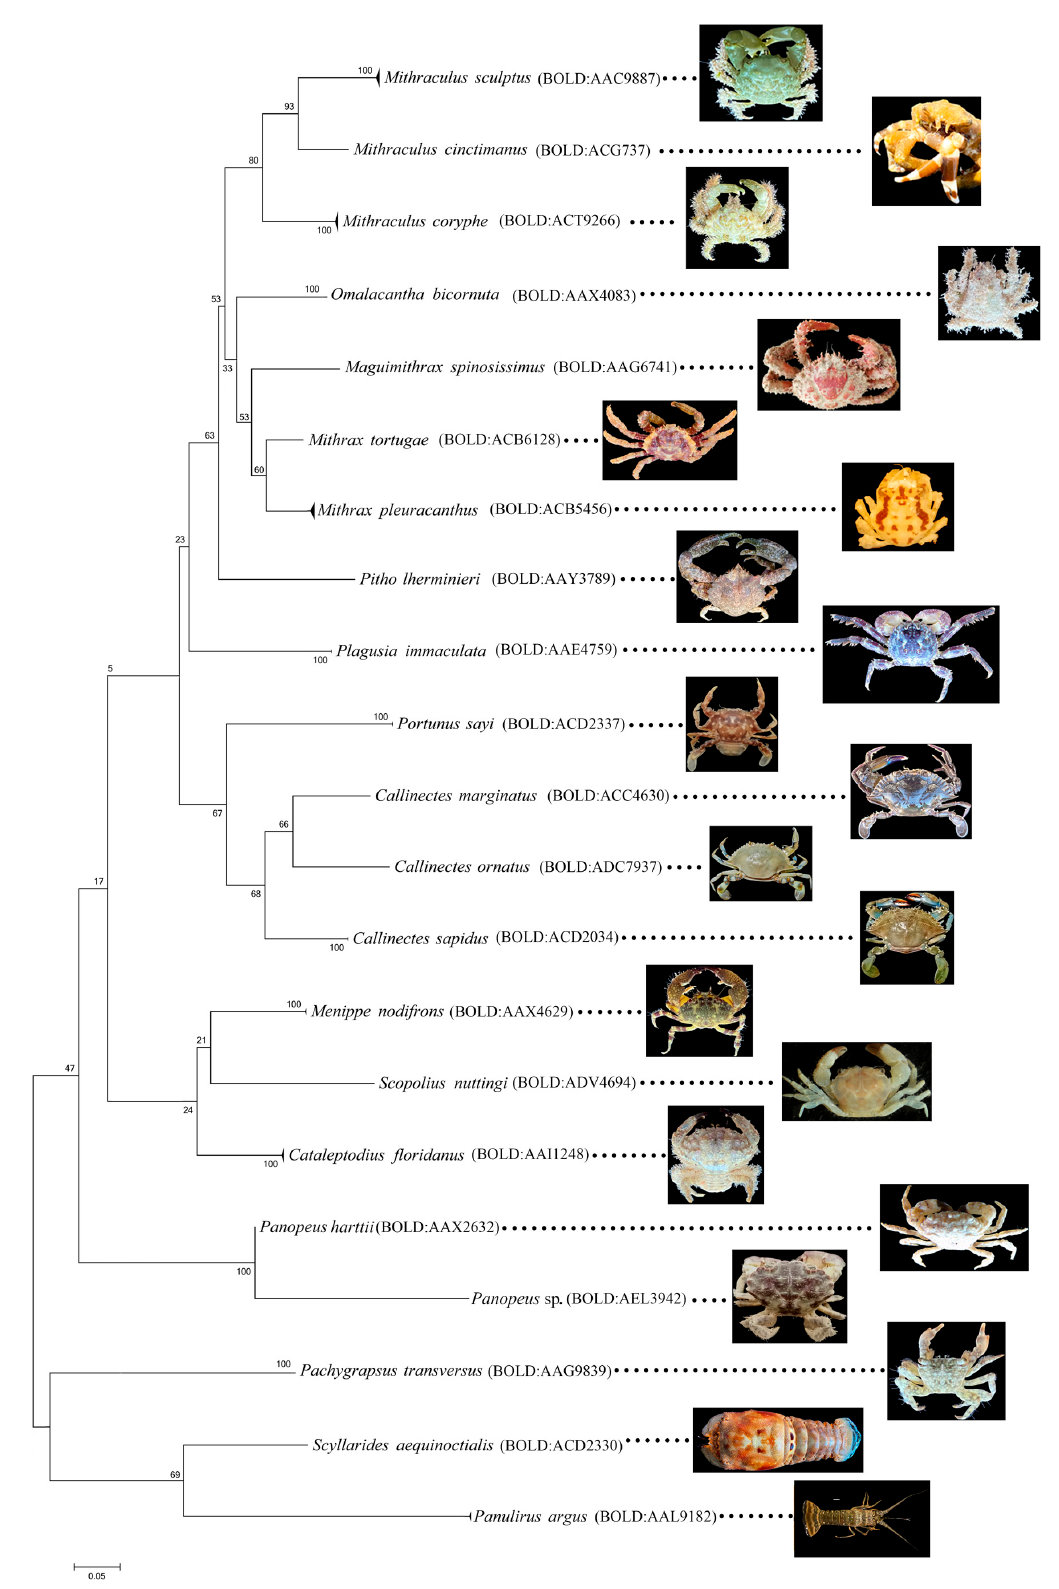
Figure 2. ID tree showing the clustering of the 21 morphotypes. The numbers on the branches are the bootstrap support after 500 replicates. Numbers after the names are the